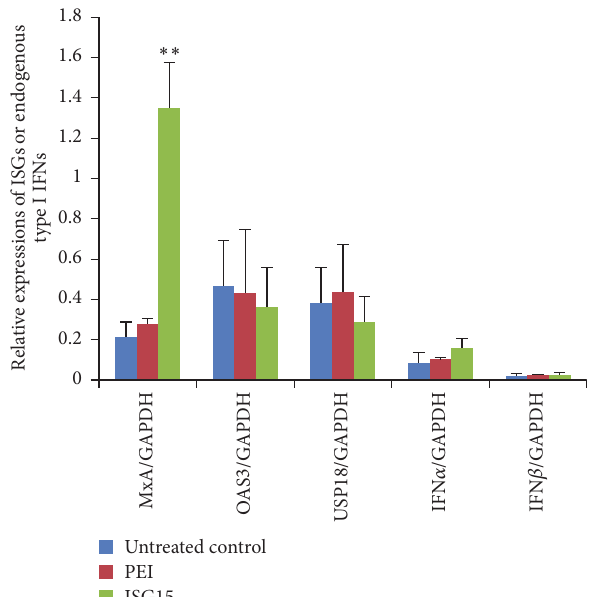
Figure 5: Effects of ISG15 overexpression on ISGs and endogenous type I IFNs . HepG2.2.15 cells were transfected with ISG15 plasmid. Real- time PCR was performed to quantify MxA, OAS3, USP18, IFN 𝛼 , and IFN 𝛽 48 h after transfection. PEI, transfection regent polyethyleneimine (PEI) treatment only; ISG15, transfected with 4 𝜇 g ISG15. ∗∗ 𝑃 < 0.01